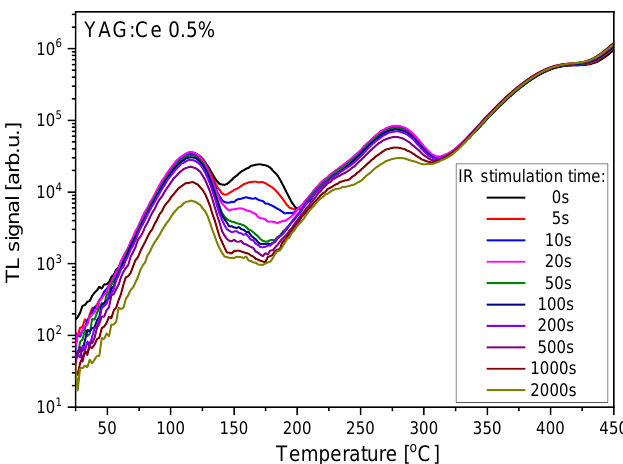
Figure 7. Influence of the variable time of IR illumination on TL glow-curves of YAG:Ce 0.5% crystal. Dose 2 Gy.